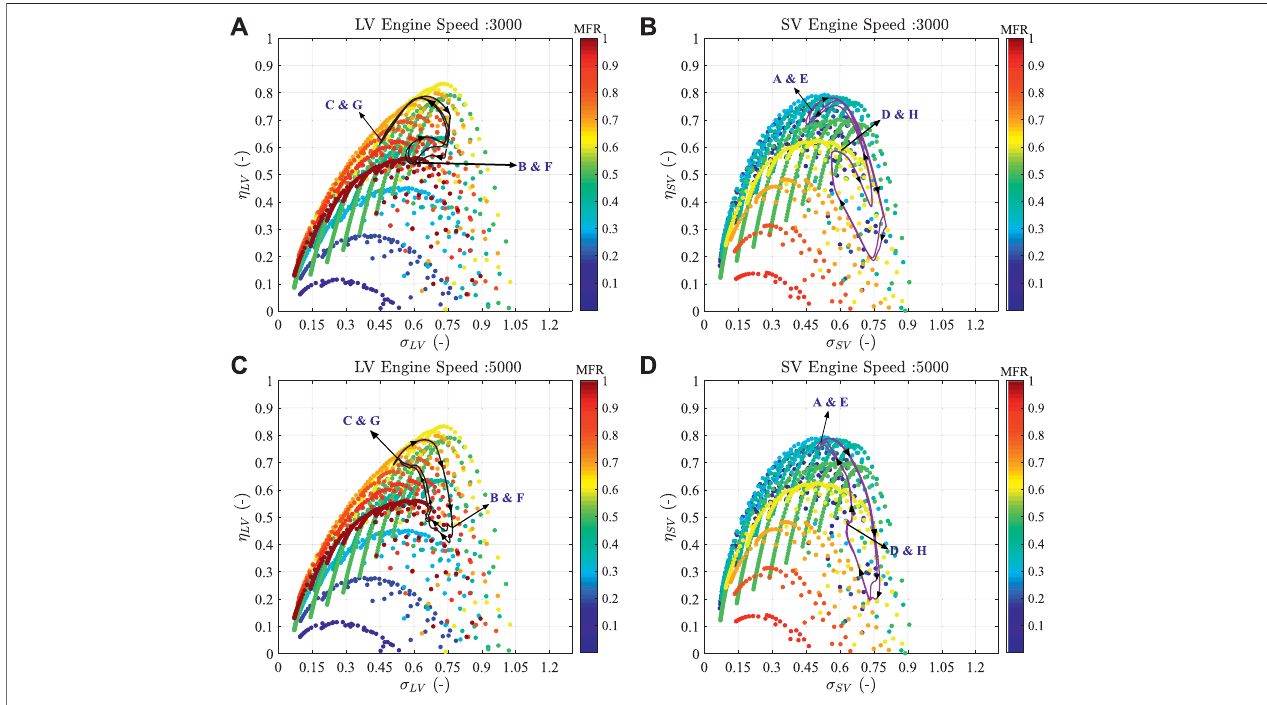
FIGURE19| Comparison ofsteady(contours)and unsteadystateparameters oftotaltostaticturbineef fi ciency(actualinstantaneousef fi ciencies)vs. bladespeed ratioacrosseachturbinebranchandfordifferentMFRlevels. (A) and (B) Showtheinstantaneousactualef fi ciencyvaluesinlongand shortvolutebranchesforanengine speed of 3,000 rpm; (B) and (D) show the instantaneous actual ef fi ciencies in long and short volute branches for an engine speed of 5,000 rpm.